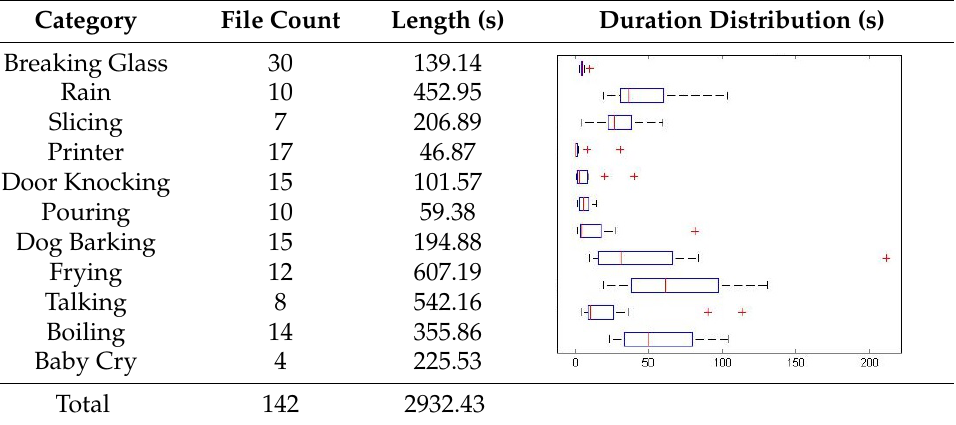
Table 1. Indoor corpus composition